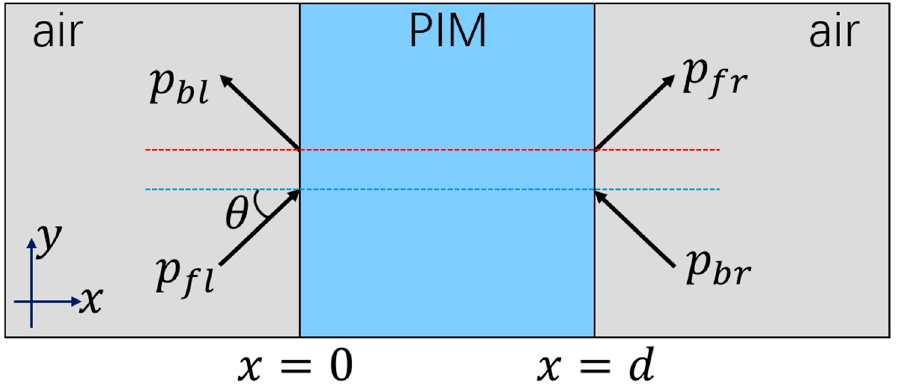
Figure 1. Schematic graph of a PIM slab in air.